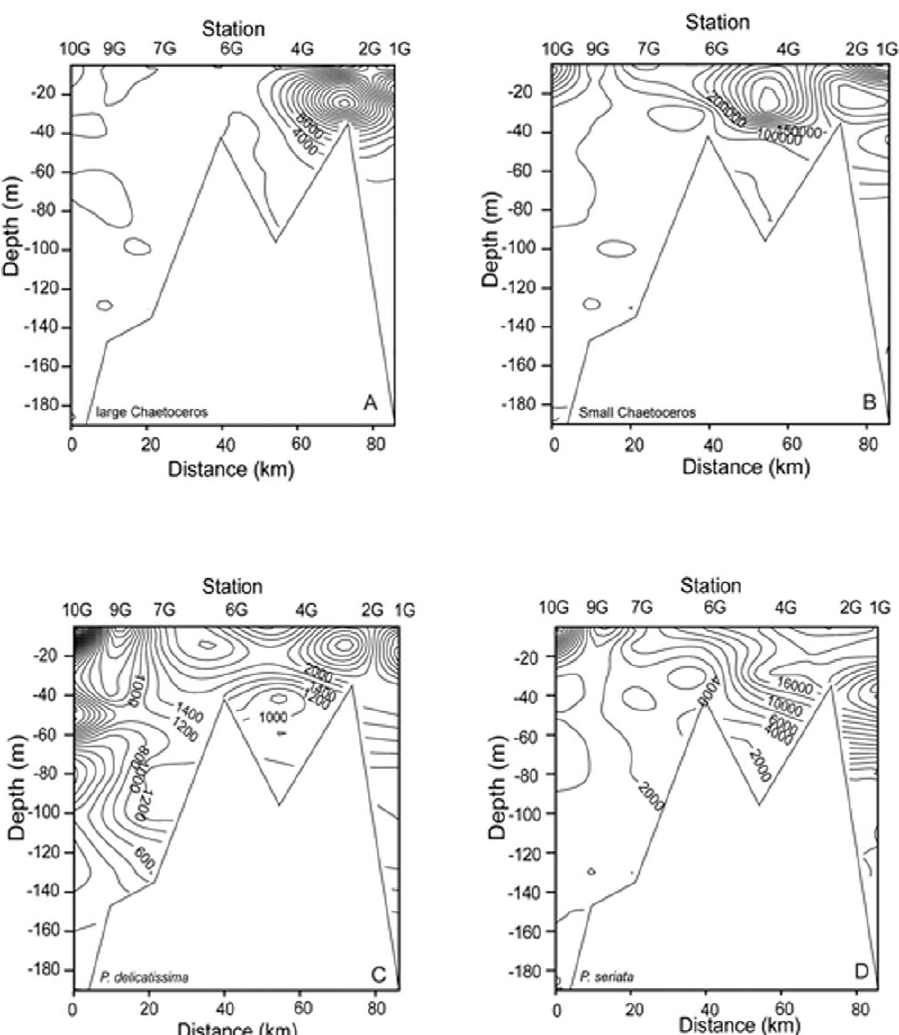
Figure 7. Contour plots of Chaetoceros and Pseudo-nitzschia on shelf. Vertical and horizontal distribution [cells L 2 1 ] of (a) large Chaetoceros spp. (b) small Chaetoceros spp. (c) P. delicatissima group (d) P. seriata group abundance, at the shelf stations (10G to